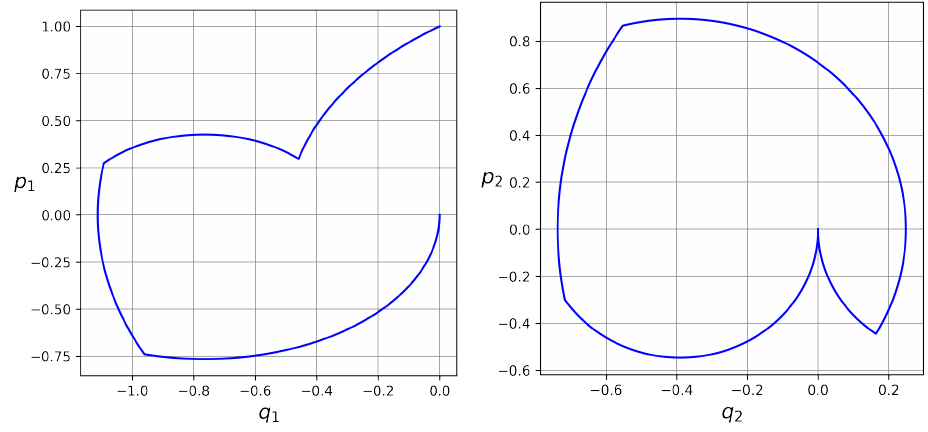
Figure 4. The phase portraits of the first and second oscillators.